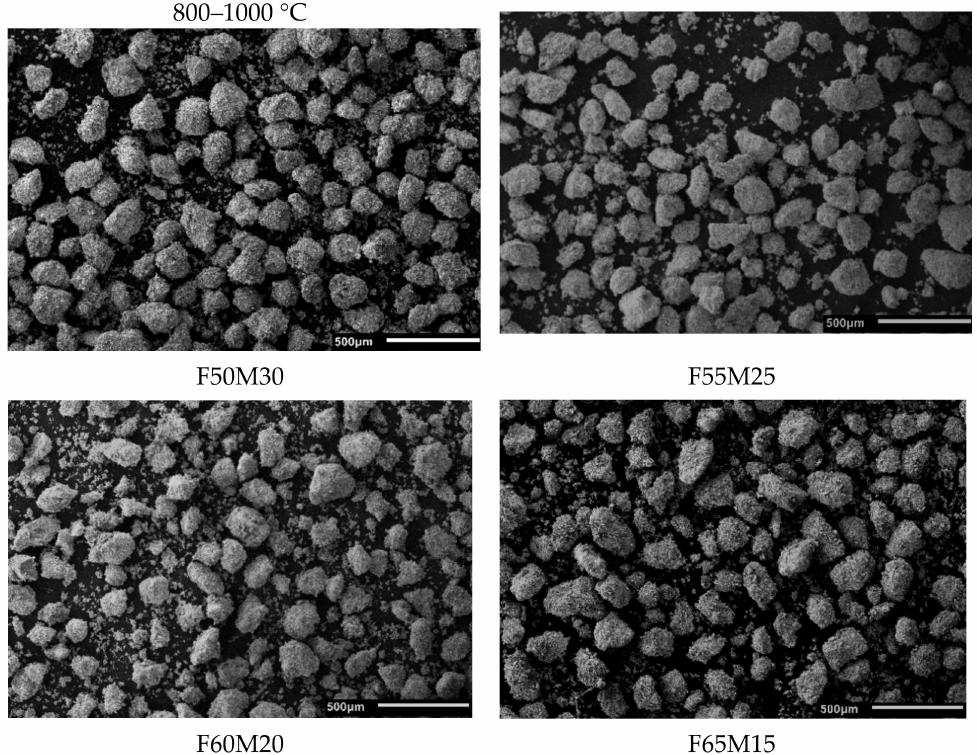
Figure 8. Scanning electron microscope photomicrographs of as-synthesized FeMn OC samples (F50M30, F55M25, F60M20 and